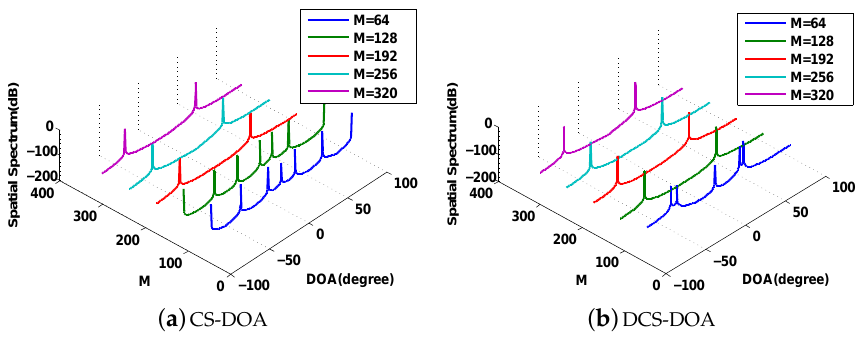
Figure 11. The comparison of DOA spatial spectrum between CS-DOA and DCS-DOA with packet size = 64.